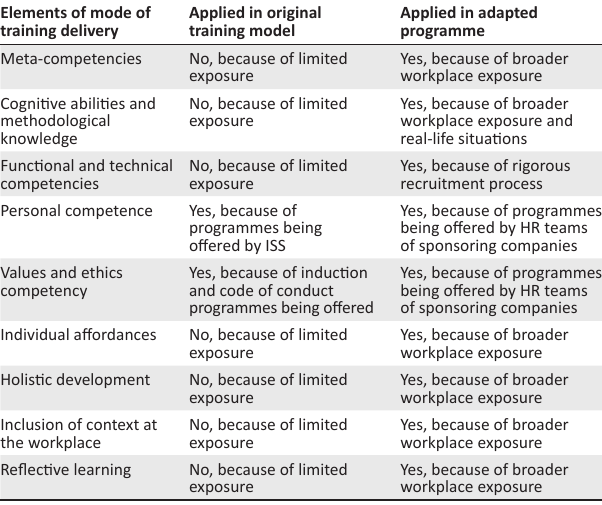
TABLE 2: Application of Adaptable Component-based Assessment Model. Elements of mode of training